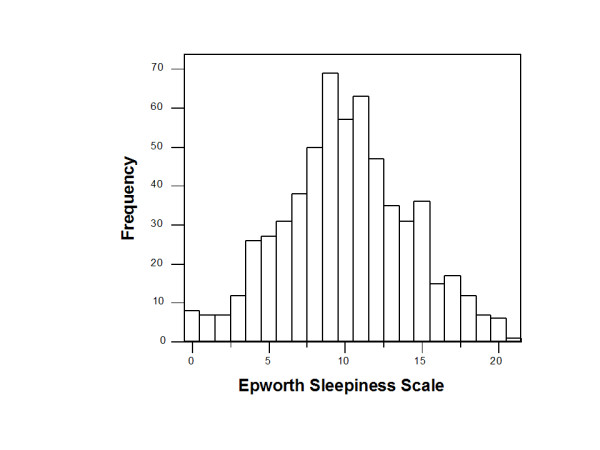
Distribution of the Epworth Sleepiness Scale score.